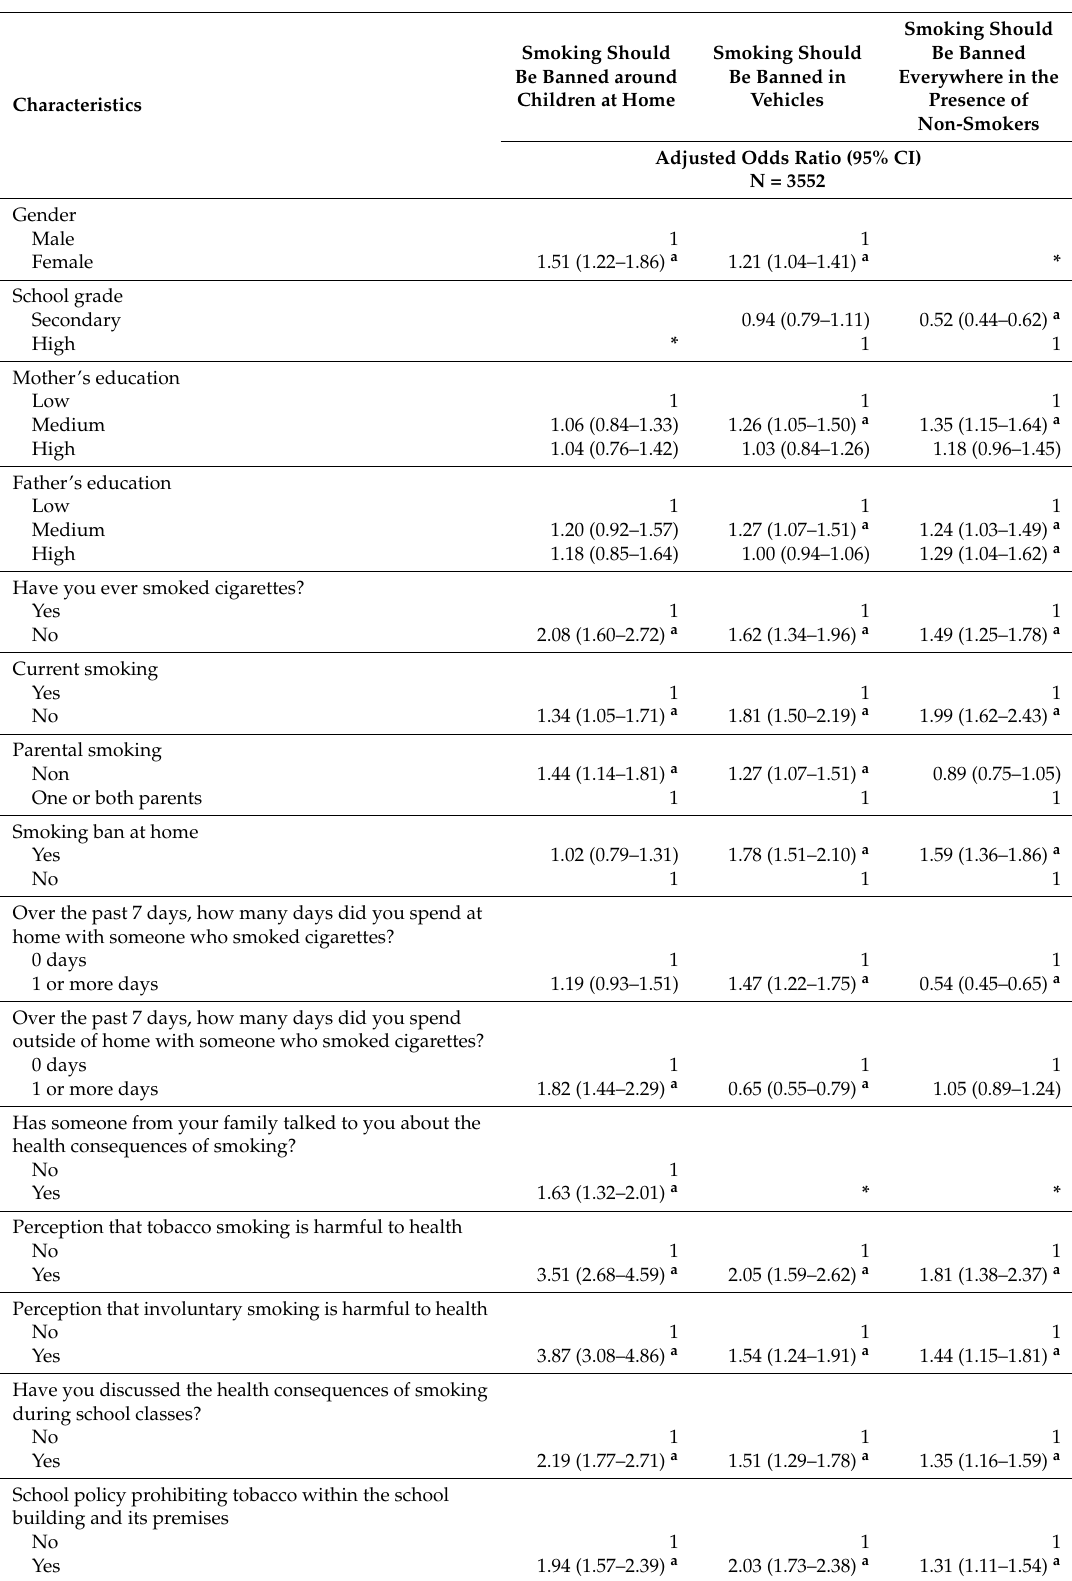
Table 3. Factors associated with the attitudes of young people towards restricting smoking in the presence of